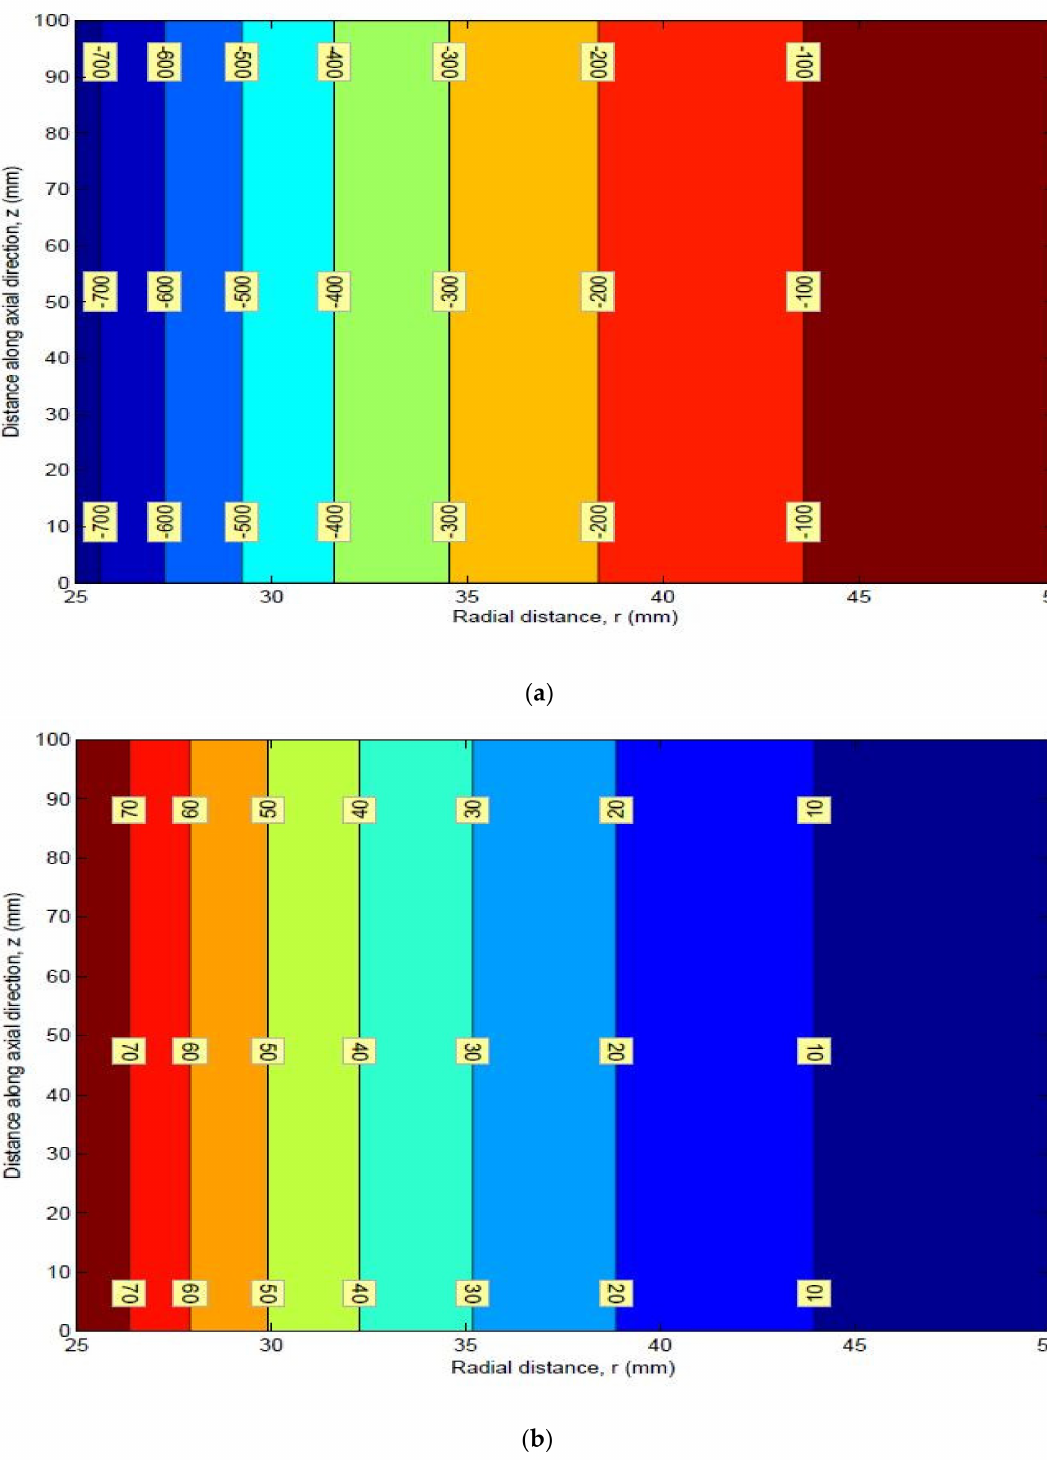
Figure 21. ( a ) Mean and ( b ) standard deviation of radial